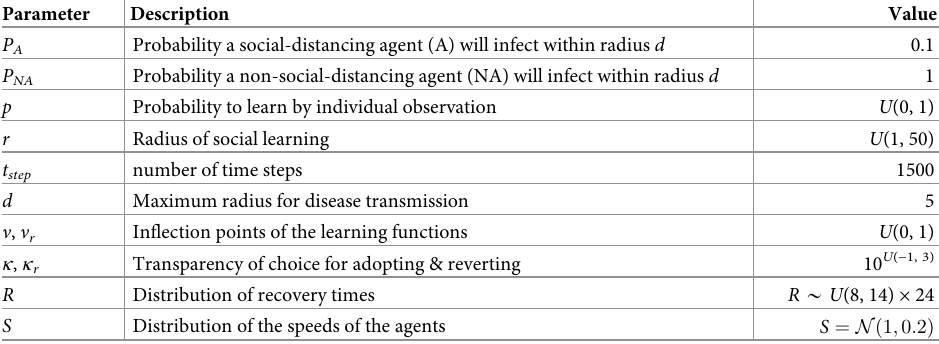
Table 1. Adjustable parameters in the agent-based simulation, with 500 agents and initialized with one infected